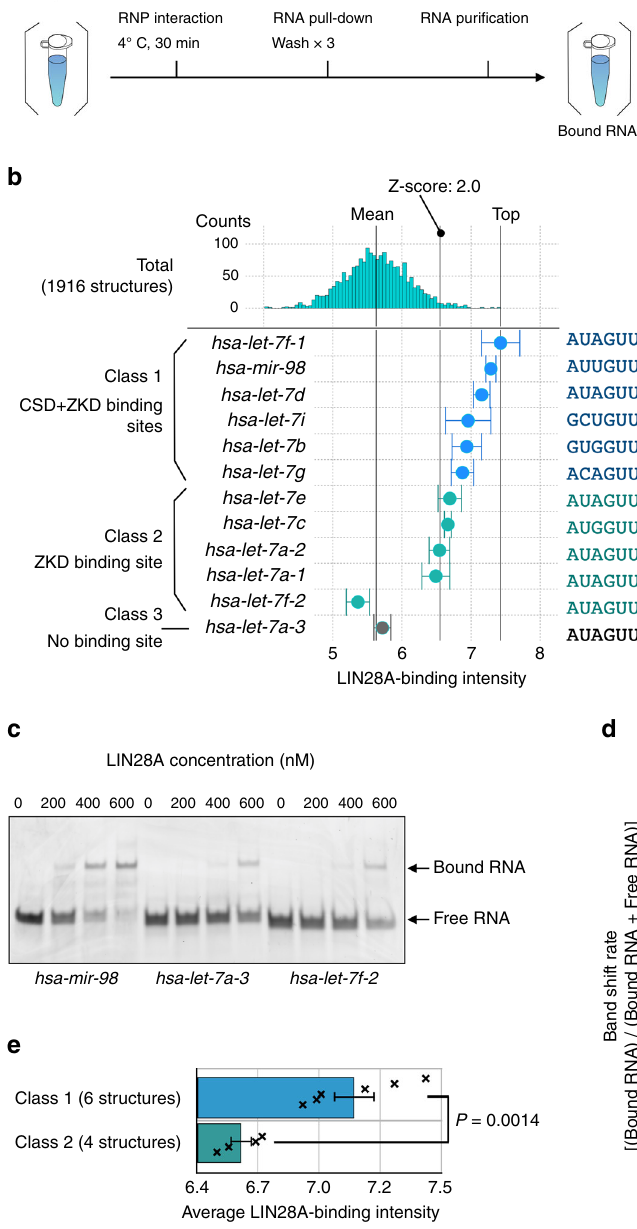
a vital component for high-af fi nity binding to speci fi c let-7 loops and the downregulation of miRNA biogenesis in cells 21